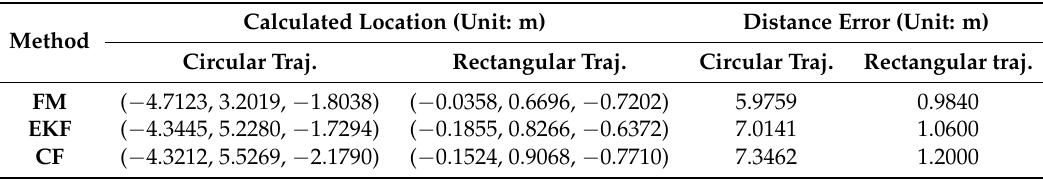
Table 4. Calculated location and distance error at destination. The location was dead-reckoned based on the attitude estimated by the considered